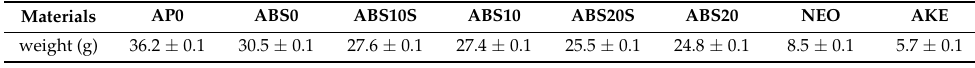
Table 3. Weights of various specimens (100 × 100 mm 2 sheet).